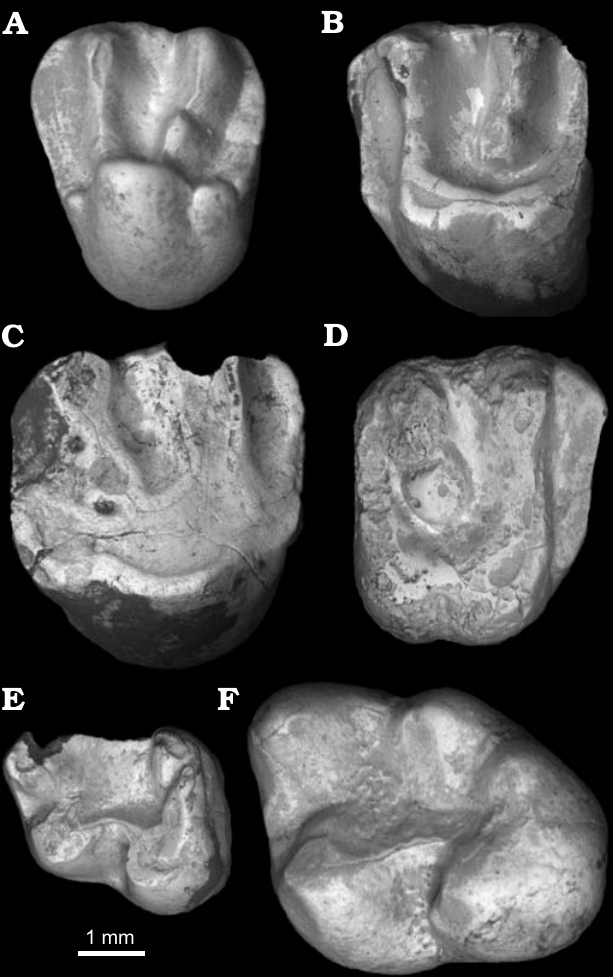
Fig. 12. Ischyromyid rodent Asiomys dawsoni Qi, 1987 from the Eocene of Wulanhuxiu, Nei Mongol, China. A . Left P4 (IVPP V20828.1). B . Left M1 (IVPP V20828.2). C . Right M1 (IVPP V20828.4). D . Right M2 (IVPP V20828.5). E . Left dp4 (IVPP V20828.6). F . Left m3 (IVPP V20828.7). All in occlusal view. Asiomys dawsoni Qi, 1987 Fig. 12. Material .—Left P4 (V20828.1), left M1 (V20828.2–3), right M1 (V20828.4), right M2 (V20828.5), left dp4 (V20828.6), left m3 (V20828.7) from Wulanhuxiu, Erlian Basin, Nei Mongol, China, middle and upper part of horizon 4, middle Eocene.